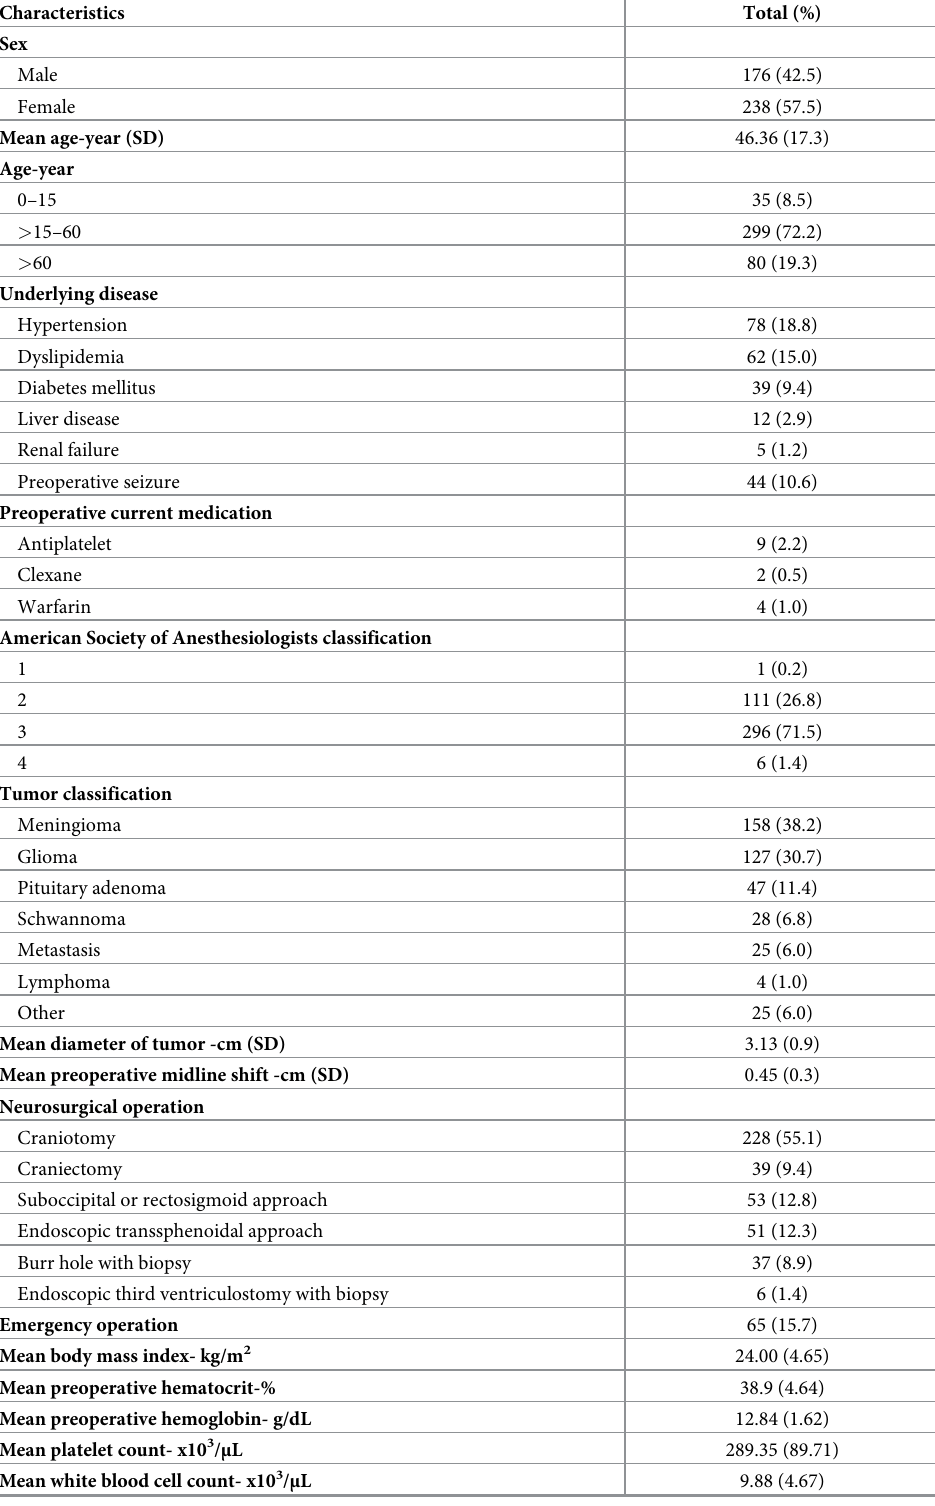
Table 3. Baseline characteristics of the second cohort (2020–2021, N =